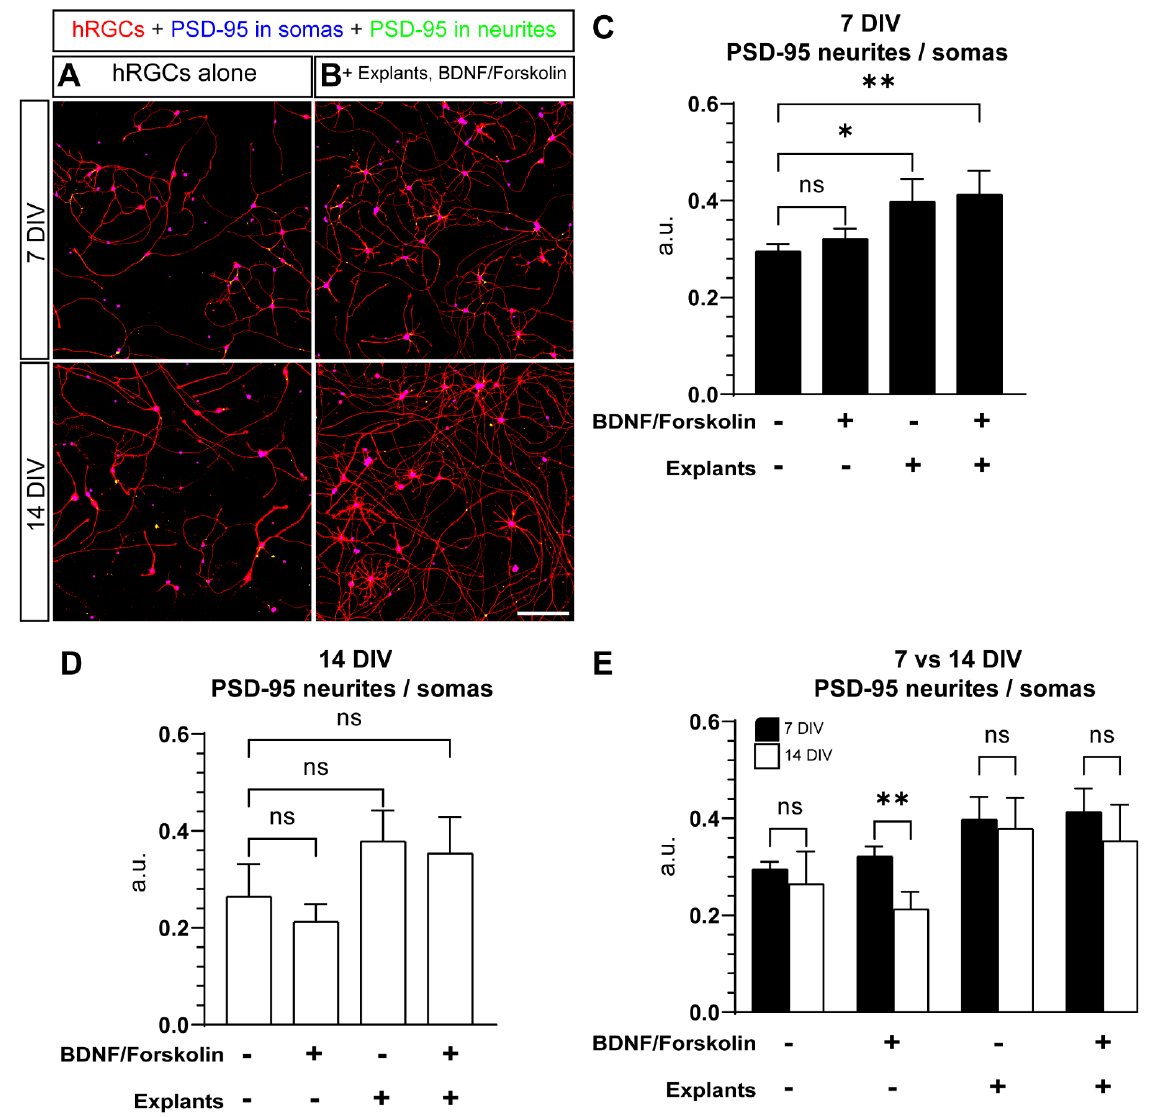
Figure 7. The effect of adult mouse retina explants and a combination of BDNF and forskolin on PSD-95 distribution in hRGCs. ( A , B ) Representative images of hRGCs immunostained against PSD-95 with an approximation of somatic and dendritic PSD-95 localization, cultured alone ( A ) or in the presence of adult mouse retina explants and a combination of BDNF/forskolin ( B ) for either 7DIV or 14DIV. ( C ) A quantification of the ratio of the area occupied by PSD-95 in neurites over PSD-95 in somas (PSD-95 neurite/soma) at 7 DIV shows that the presence of adult mouse retina explants without and with the inclusion of BDNF+ forskolin, increases PSD-95 neurites/somas ( p = 0.0249, p = 0.0112 respectively). ( D ) At 14 DIV, supplementation with BDNF, Forskolin or the presence of explants did not significantly alter PSD-95 neurite/soma compared to hRGCs cultured alone. ( E ) A comparison between PSD-95 neurites/somas at 7 and 14 DIV. PSD-95 neurite/soma is lower at 14 DIV when supplemented with BDNF, Forskolin ( p = 0.0055), Scale bar = 200 μm. Data are shown as mean ± SEM, * indicates p < 0.05, ** indicates p < 0.01, ns = no significance. Statistical significance was tested using an ordinary one-way ANOVA, Dunnett’s post hoc test. 7DIV hRGCs alone: N = 3 coverslips, n = 3 2.9 × 2.9 mm images, 7DIV + BDNF, forskolin: N = 3, n = 3, 7DIV + explants: N = 4, n = 3–4, 7DIV + explants + BDNF, forskolin: N = 4, n = 3–5, 14DIV hRGCs alone: N = 4, n = 3, 14DIV + BDNF, forskolin: N = 4, n = 3, 14DIV + explants: N = 3, n = 3–4, 14DIV + explants + BDNF, forskolin: N = 4, n =